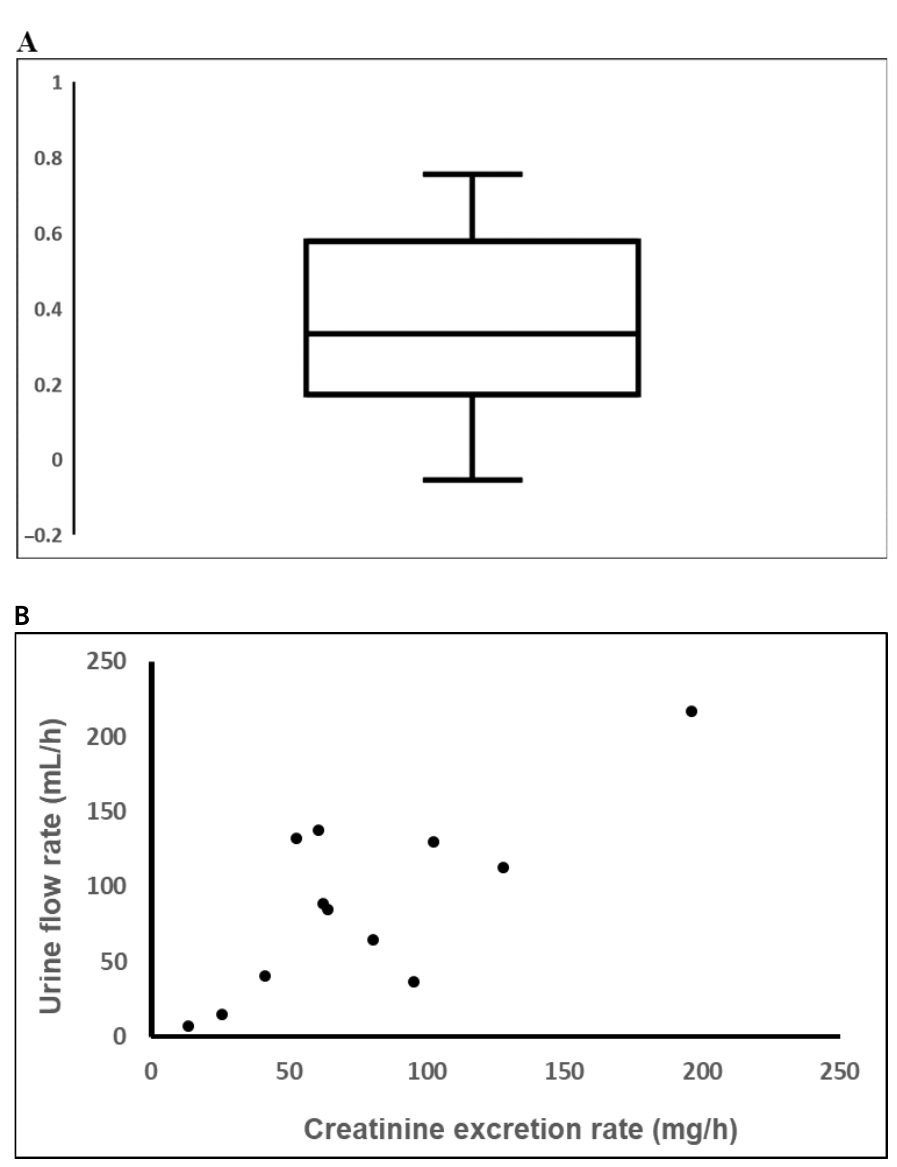
Figure 3. ( A ) Distribution of individual Spearman correlation coefficients for the association between creatinine excretion rate and urinary flow rate in 60 individuals. The box plot shows the 10th, 25th, 50th, 75th, and 90th percentiles. ( B ) The relationship for 12 spot samples in one individual (r s = 0.55).